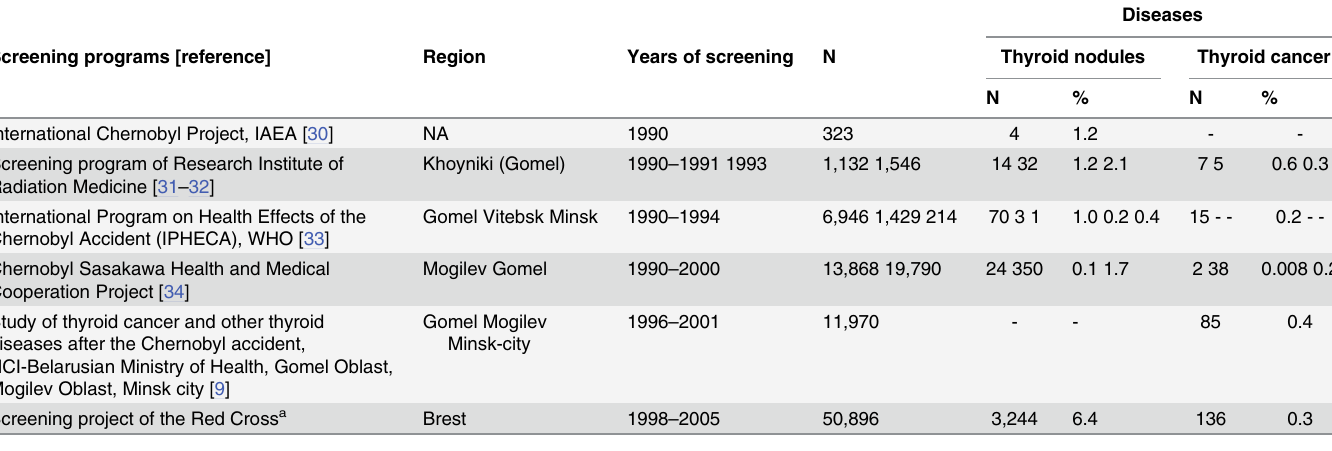
Table 2. Results of ultrasound screening programs for thyroid nodules and thyroid cancer in Belarus after the Chernobyl accident.